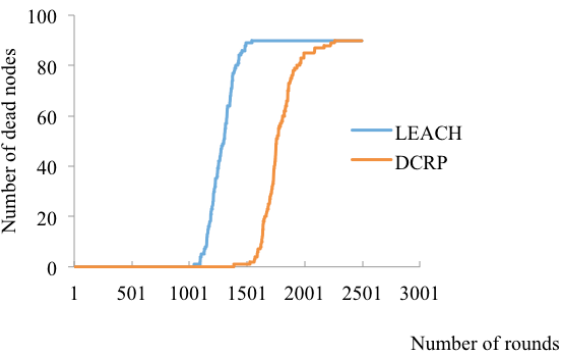
Fig. 7. Comparison between DCRP and